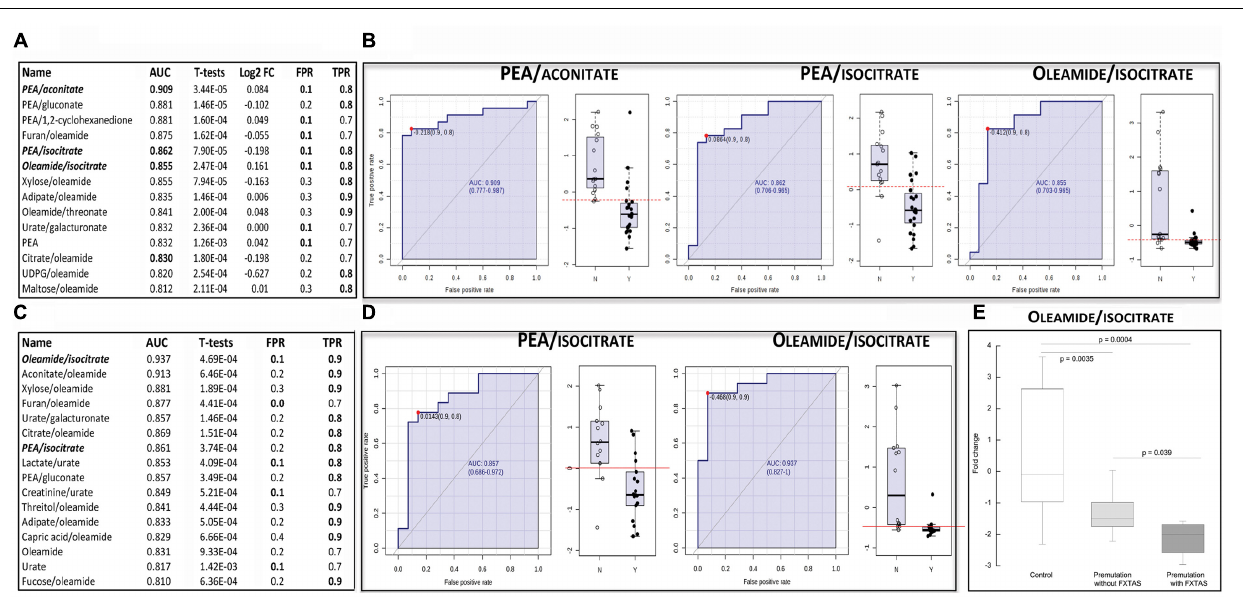
FIGURE 1 | Metabolites and their ratios as potential biomarkers of the premutation. (A) The displayed biomarkers were obtained by using data from all controls and premutation carriers (reported in Table 1 ). The complete list of metabolites identified by mass spectrometry is reported in Supplementary Table S1 . Metabolites’ performance was filtered based on their area under ROC curve (AUROC ≥ 0.800) and T-statistics ( p ≤ 0.05). Also shown are the generalized log transformation of the fold change (Log FC), false positive rate (FPR) and true positive rate (TPR). In bold, biomarkers with FPR ≤ 0.1 and TPR ≥ 0.8. (B) Receiver operator characteristic (ROC) curves of the model using metabolite ratios identified under A as potential biomarkers. The X-axis represents the FPR (as 1-specificity) whereas the Y-axis represents the sensitivity. On the right side of each ROC, box whisker plots of the generalized log transformation of fold change ratios in control (N) and premutation carriers (Y). (C) As in A but analysis performed with subjects not taking SSRIs (those excluded were indicated with asterisks under Table 1 ). (D) ROC curves of the model using metabolite ratios identified under C as potential biomarkers (other details under B). (E) Differences in the plasma biomarker oleamide/isocitrate in controls and carriers of the premutation with and without FXTAS. Data are shown as fold change and were analyzed by ANOVA followed by Bonferroni’s post-hoc test.